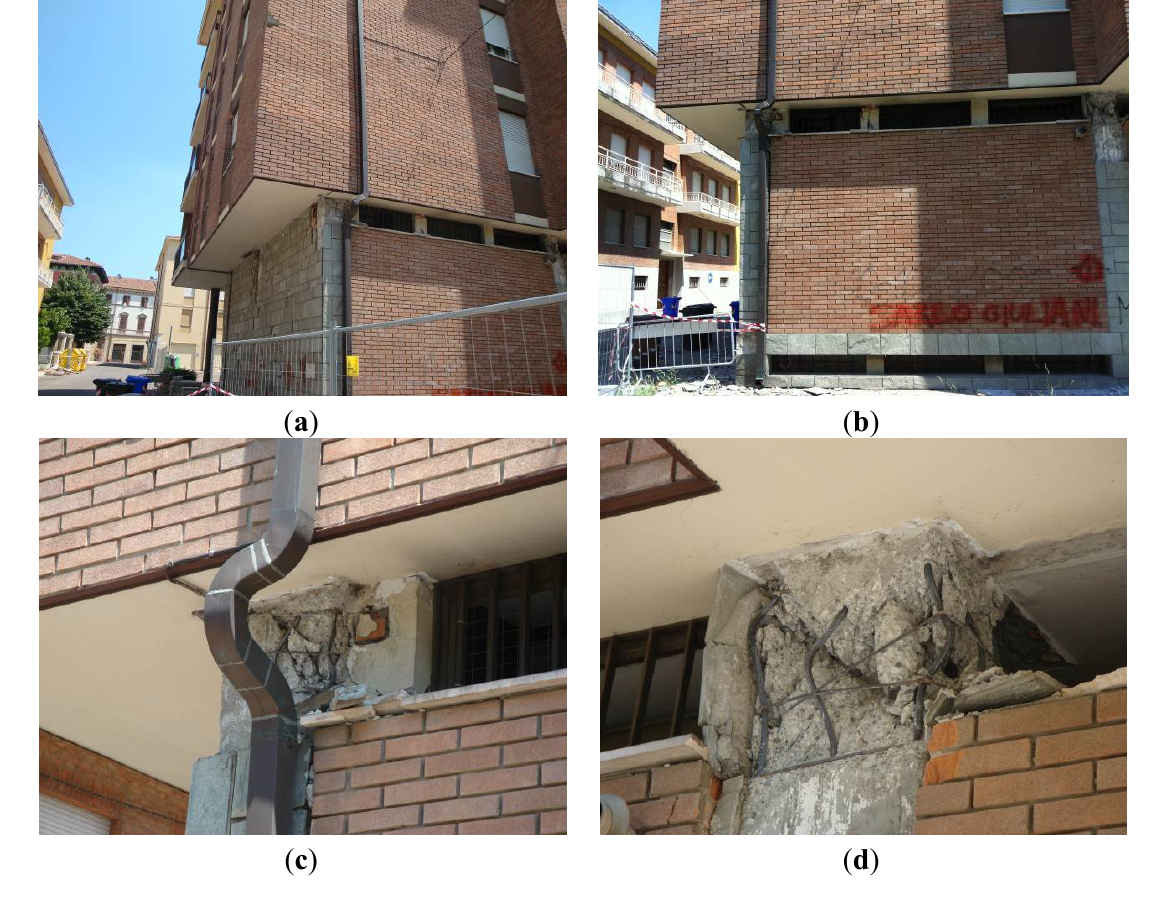
Figure 12. ( a ) Corner view of damaged building; ( b ) Partially infilled RC frame at the ground floor; ( c ) Shear failure of corner column; ( d ) Shear failure of peripheral